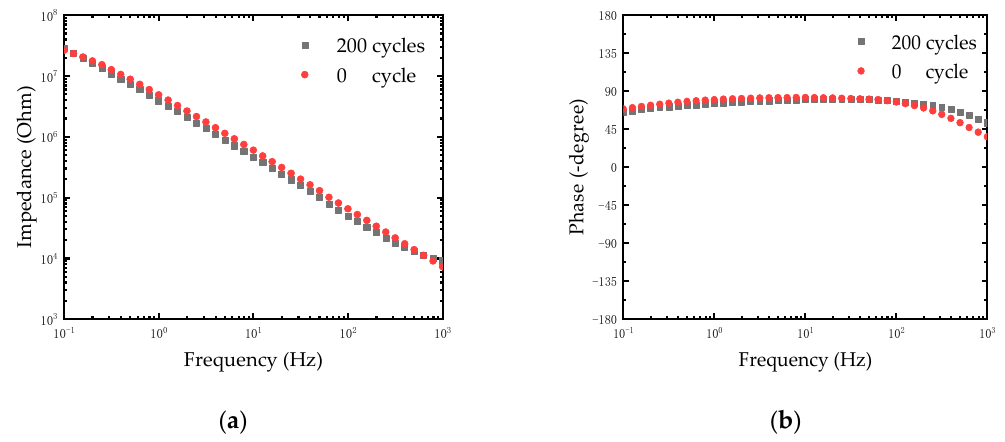
Figure 6. ( a ) Impedance plot of modified Ag/AgCl electrode treated with different cycles of CV scanning. ( b ) Phase spectra of modified Ag/AgCl electrode treated with different cycles of CV scanning.